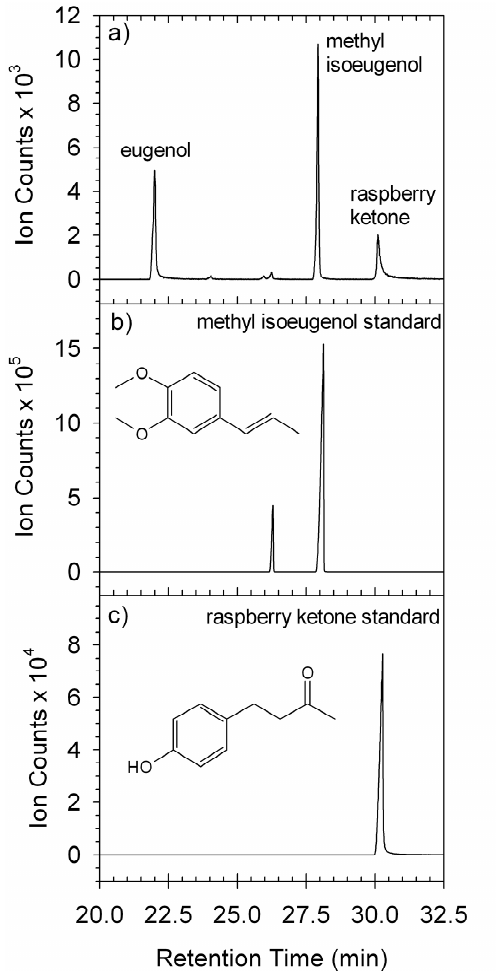
F IGURE 2. Gas chromatogram of a) underivatized whole flower extract of P. thurberi, b) methyl isoeugenol standard, and c) raspberry ketone standard. Chromatogram is filtered to show only 164 and 178 ions in order to remove several artifactual peaks arising from siloxane contaminants.